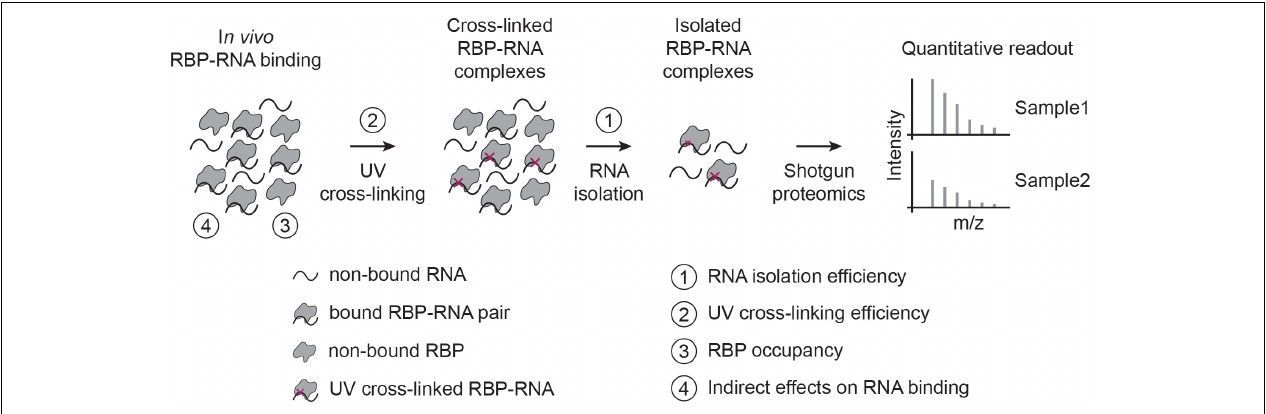
FIGURE 1 | RIC-like assays and biases involved in quantifying RBP-RNA interactions. In RIC-like experiments, in vivo RBP-RNA interactions are stabilized by UV cross-linking. RNAs are isolated and the bound proteome is quantified with shotgun proteomics. We identify here four biases in the interpretation of RBP-RNA quantification results: RNA isolation (1), UV cross-linking (2), RBP occupancy (3), and indirect effects on RNA binding